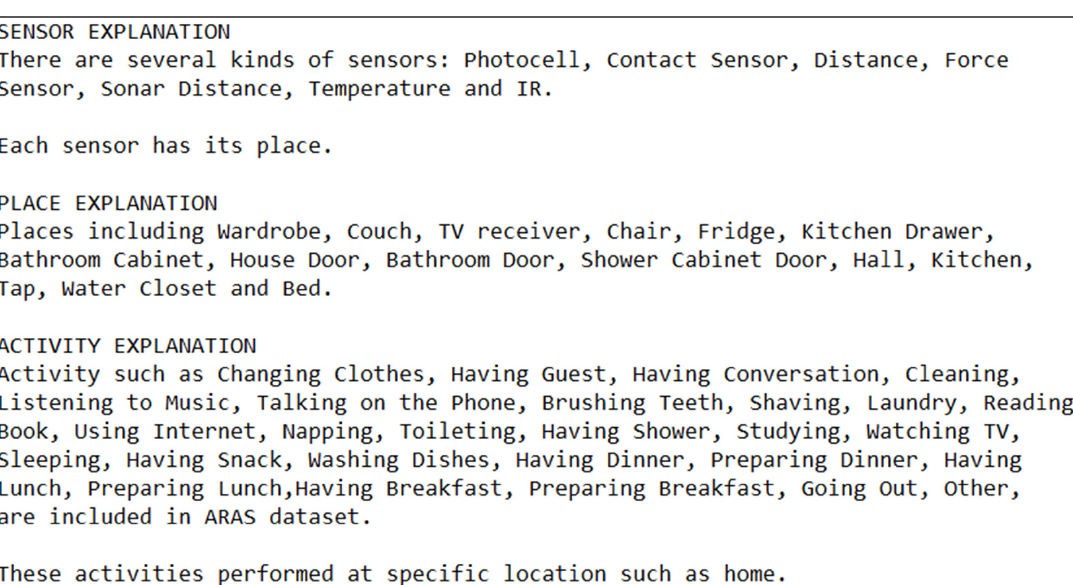
of the ARAS dataset . (cid:2870)